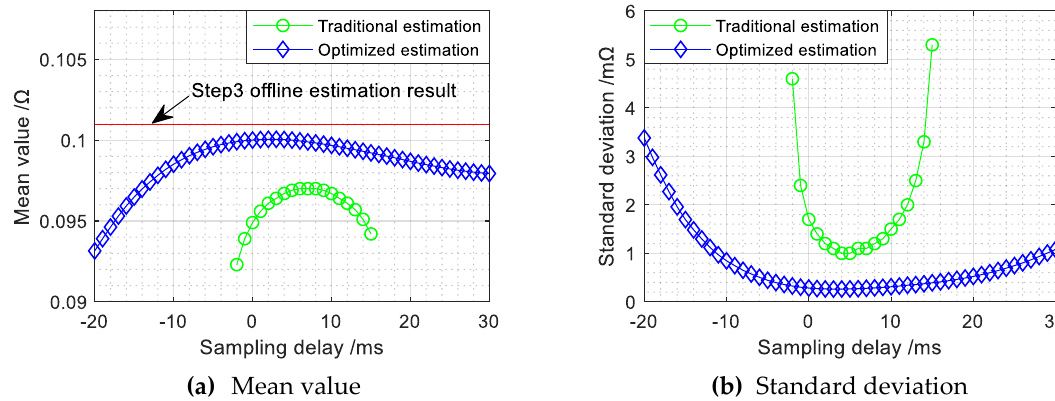
Figure 14. The mean value and standard deviation of estimated internal resistances under different sampling delays.